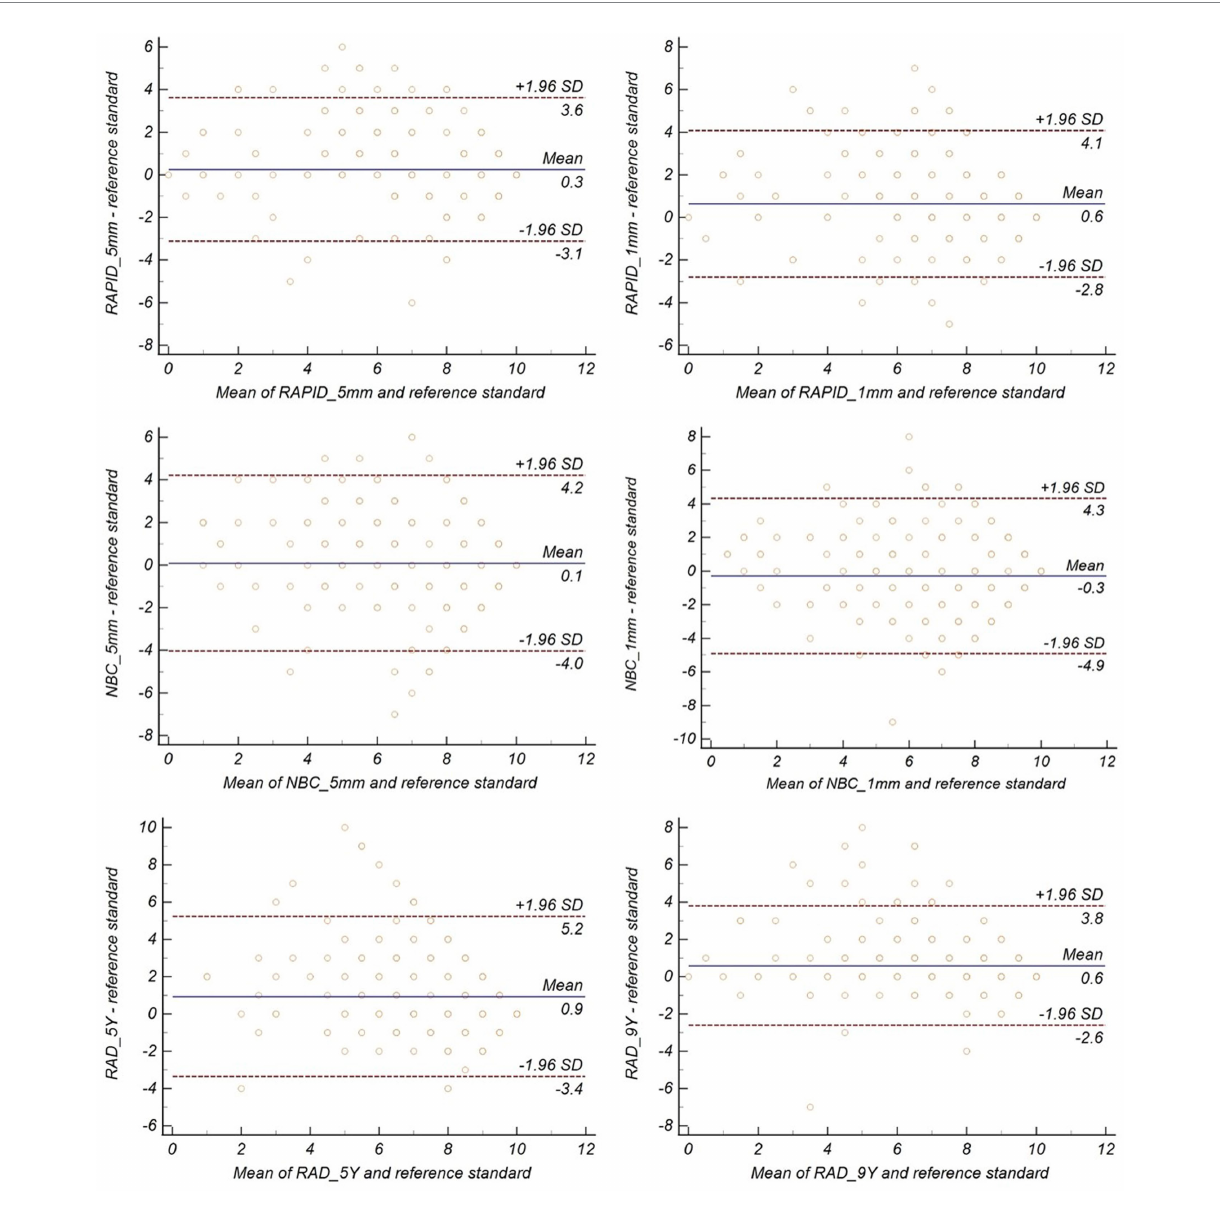
FIGURE 3 Bland–Altman plots for agreement between baseline ASPECTS and reference standard.